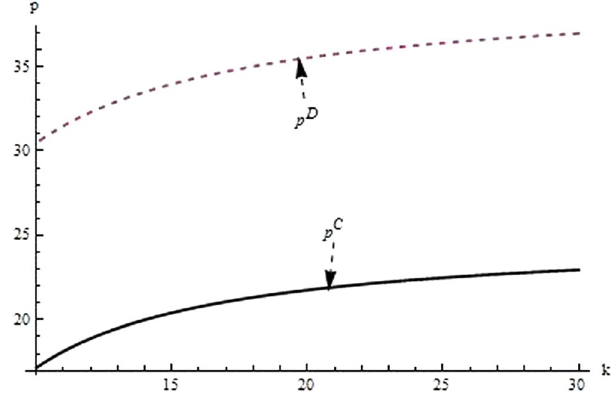
Figure 1. The impact of the reduction difficulty coefficient on the product price.